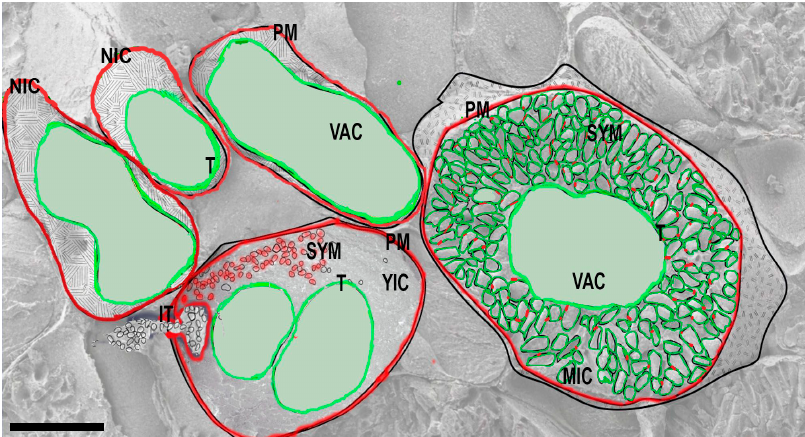
Figure 1. The change in the symbiosome membrane’s identity during the development and matura- tion of infected cells. The membrane of the symbiosome in a young infected cell (YIC) contains a fragment of the plasma membrane (PM, marked in red) as an integral part and contains markers of plasma-membrane-targeted exocytosis. In a mature infected cell (MIC), symbiosomes accept tonoplast-resident vacuolar SNAREs and markers of endosomes (marked in green) but also retain some plasma-membrane markers (red dots). Abbreviations: NIC—non-infected cell, YIC—young infected cell, MIC—mature infected cell, VAC—vacuole, T—tonoplast, PM—plasma membrane, IT—infection thread, SYM—symbiosomes. Bar: 12.5 µ